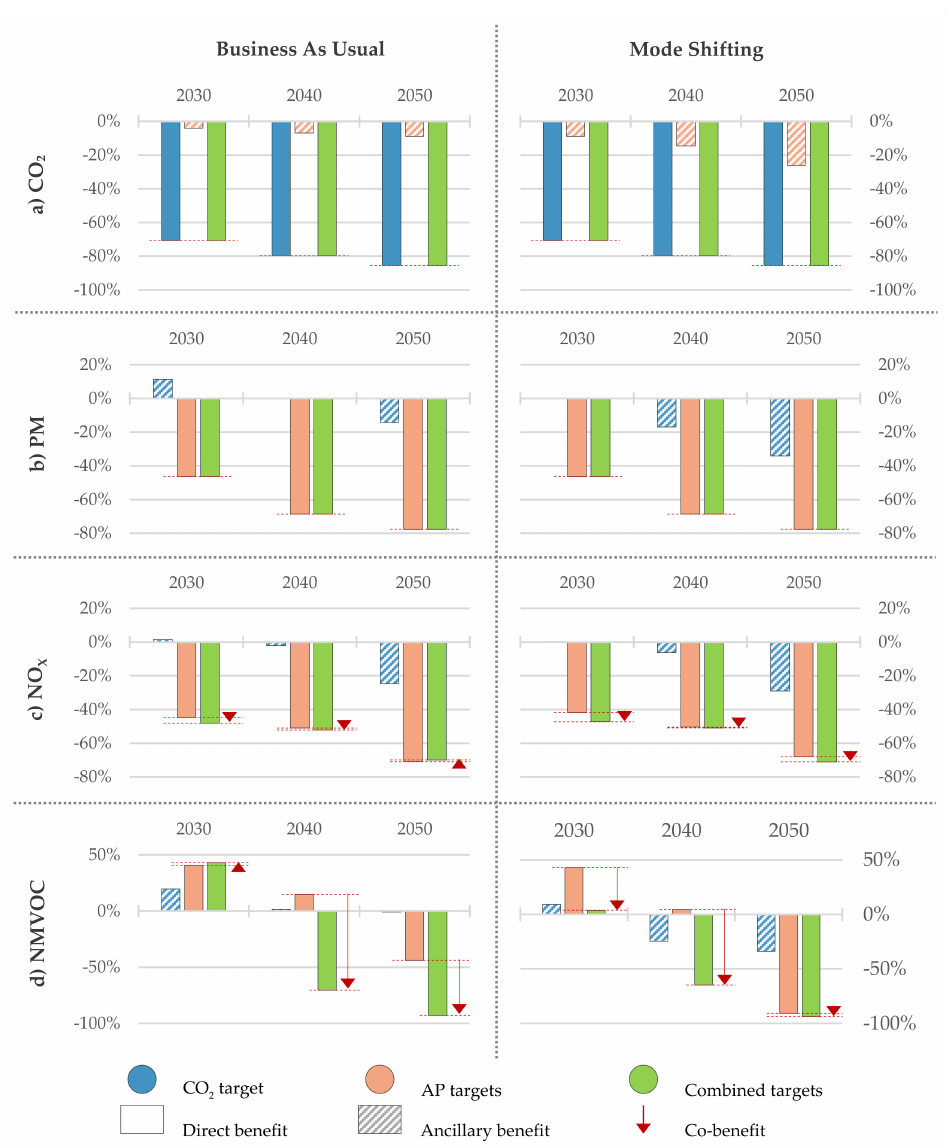
Figure 8. Additional (relative) change in emissions of ( a ) carbon dioxide (CO 2 ), ( b ) particulate matter (PM), ( c ) nitrogen oxides (NO X ), and ( d ) non-methane volatile organic compounds (NMVOCs), compared with the business-as-usual reference scenario ( BAU_REF ) under different mitigation targets. Note : Solid blue bars = direct benefit for CO 2 emissions from CO 2 mitigation target; dashed blue bars = ancillary benefits for AP emissions from CO 2 mitigation target; solid red bars = direct benefits for AP emissions from AP targets; dashed red bars = ancillary benefits for CO 2 emissions from AP mitigation targets; green bars = impact of combining all mitigation targets; arrows = positive or negative co-benefits from combined mitigation